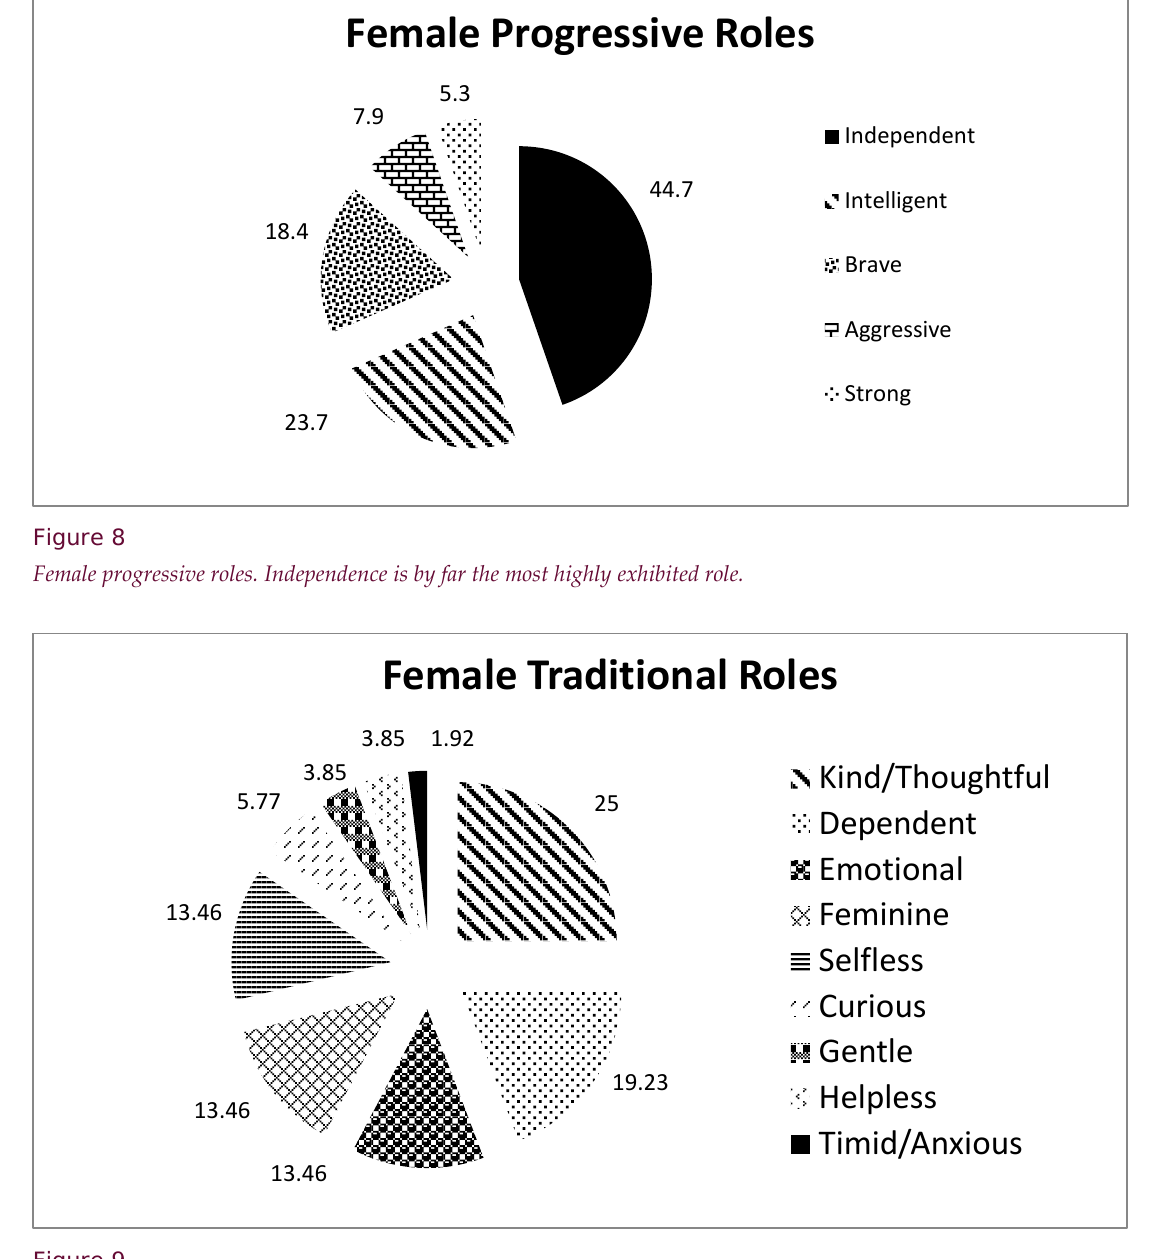
Featured female traditional roles in female characters. To assist in this chart’s comprehension, the roles have been organized clockwise: “Kind/Thoughtful” begins with portion with diagonal lines, followed by “Dependent” with white dots, etc., going clockwise on the chart. Gender depiction greatly differs from one story to the next. Males exhibit more traditional than progressive roles, while females have nearly a balance between the two categories. The ratio is approximately 5:1, with 38 progressive role instances for females and 7 progressive role instances for males. For traditional traits, 42 traditional role instances were observed for females versus 74 traditional role instances for males (Figure 6 and Figure